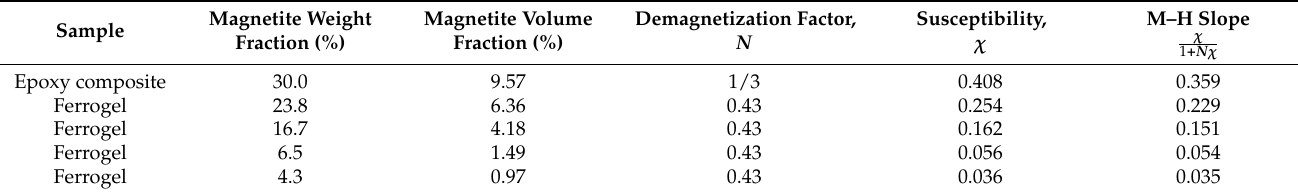
Table 2. Parameters related to the calculation of the susceptibility of the ferrogel samples.